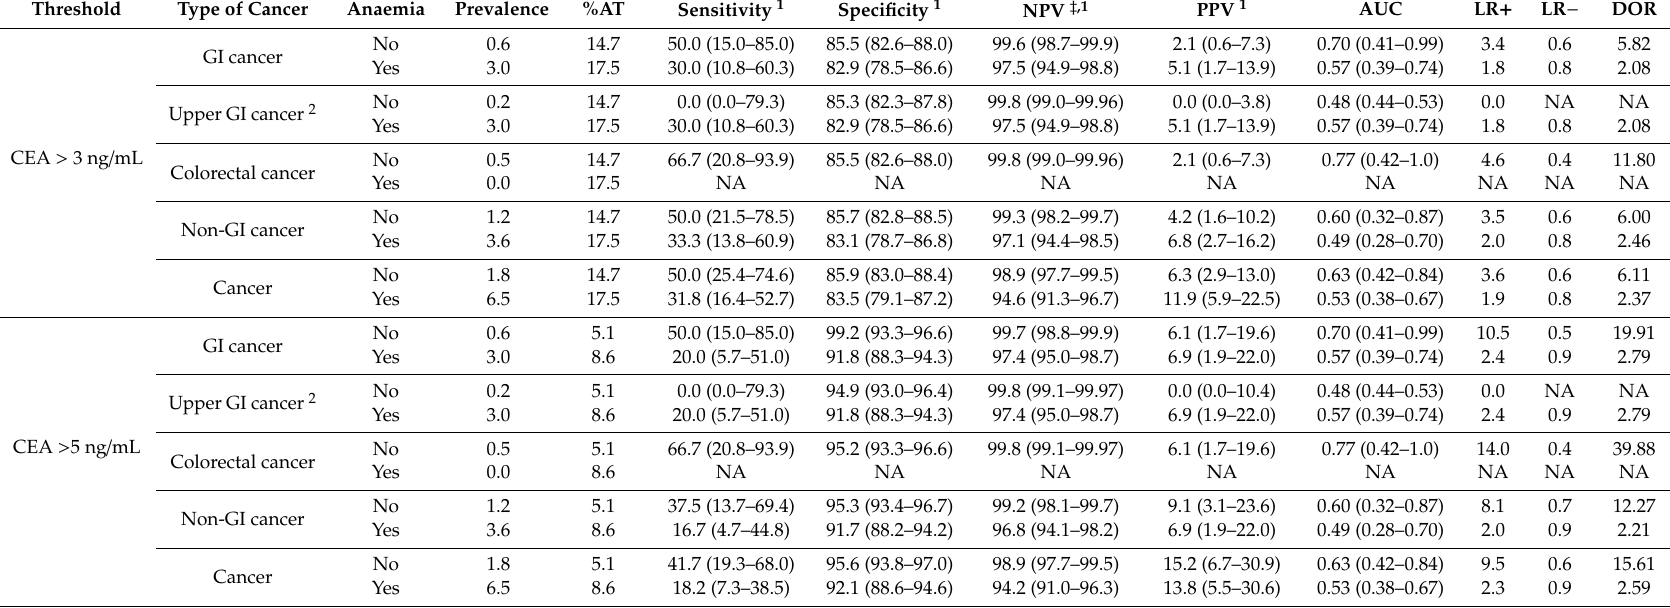
Table 4. Diagnostic accuracy of carcinoembryonic antigen for di ff erent types of cancer diagnosed in the first year during